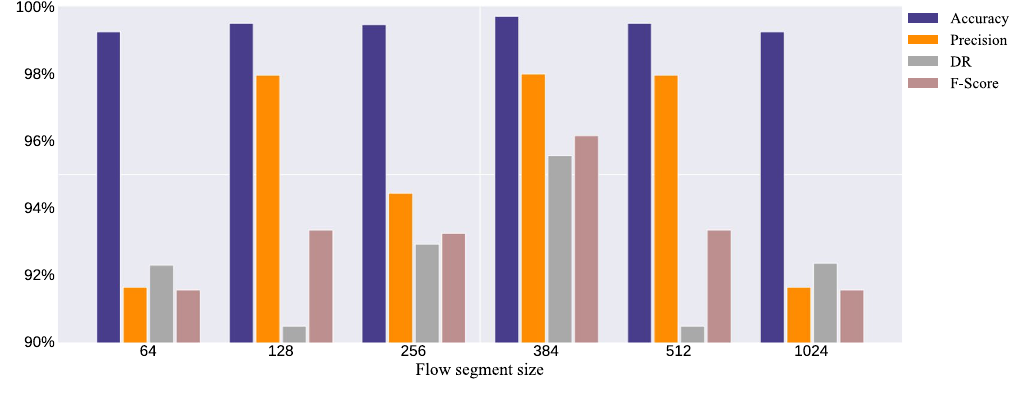
Figure 7. Influence of flow segment size on the proposed